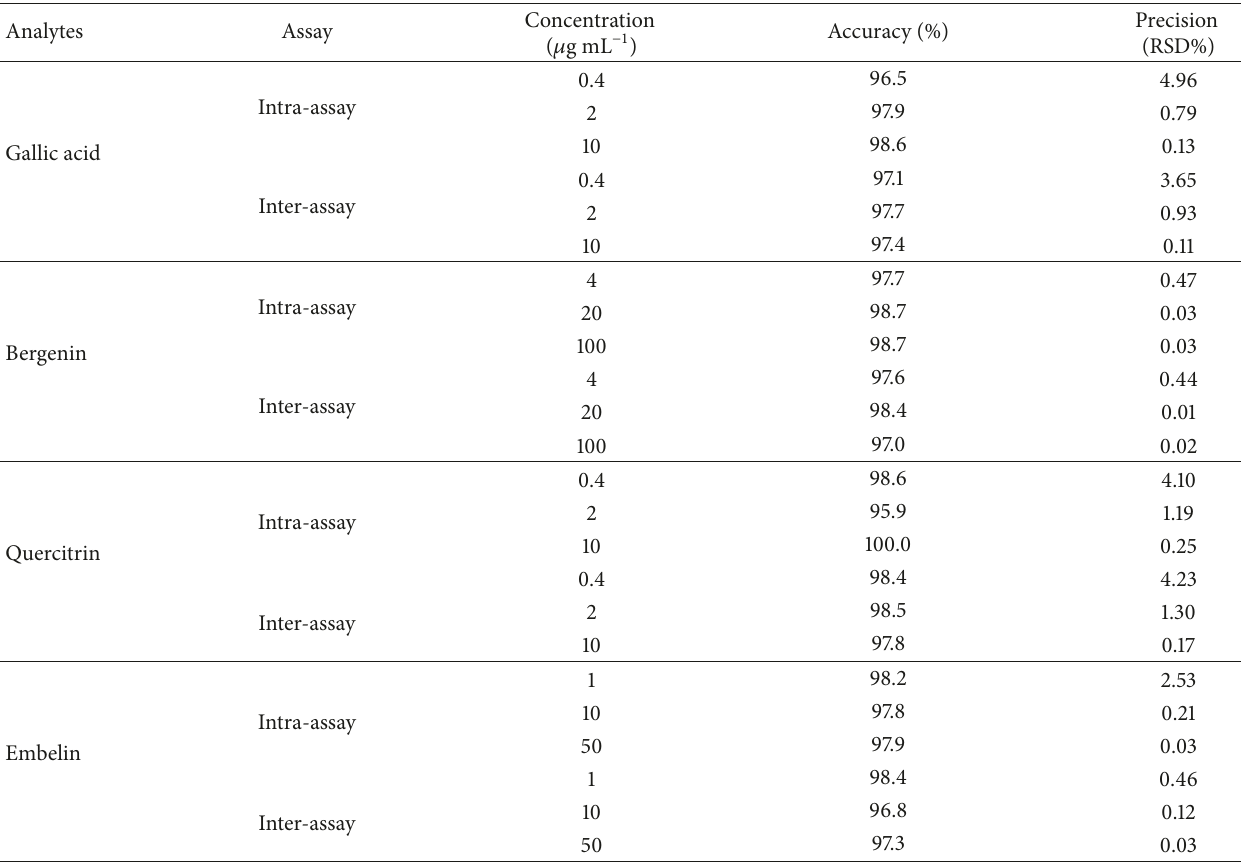
Table 2: Precision and accuracy of the method (𝑛 = 6) .